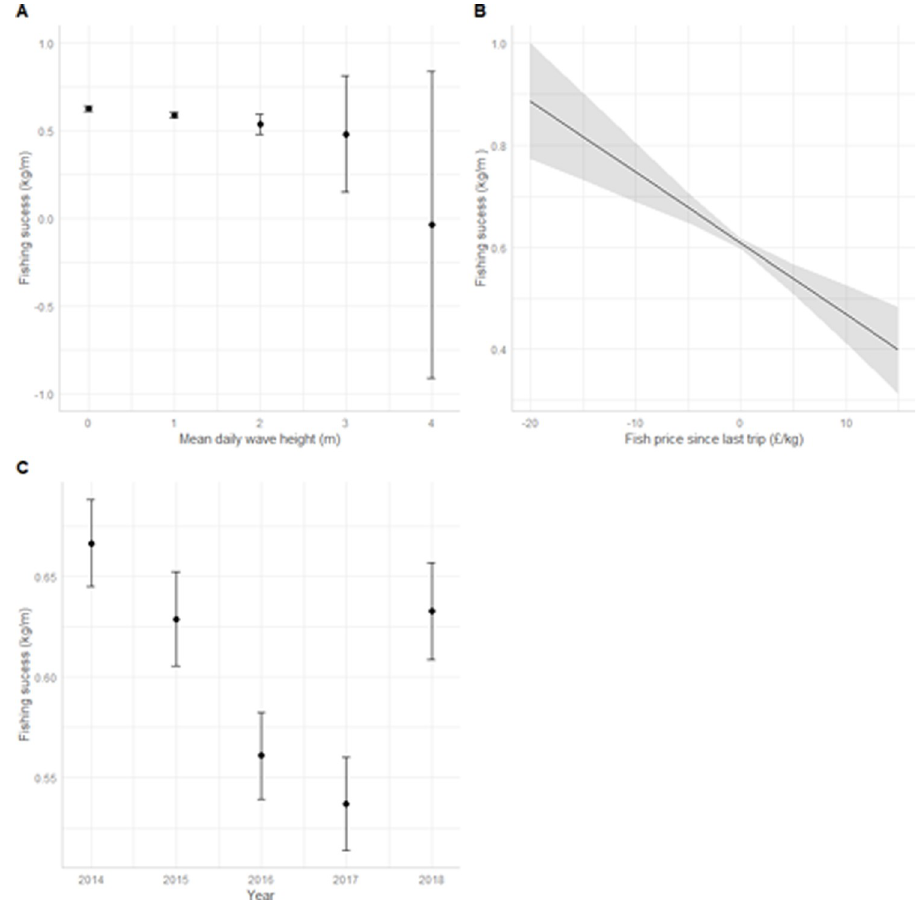
Fig 3. Effects of predictors on fishing success, from the regression analysis (Eqn. 2). A) Effect of mean daily wave height; B) Change in fish price from last trip; C) year the fishing trip took place. Bars and bands indicate confidence